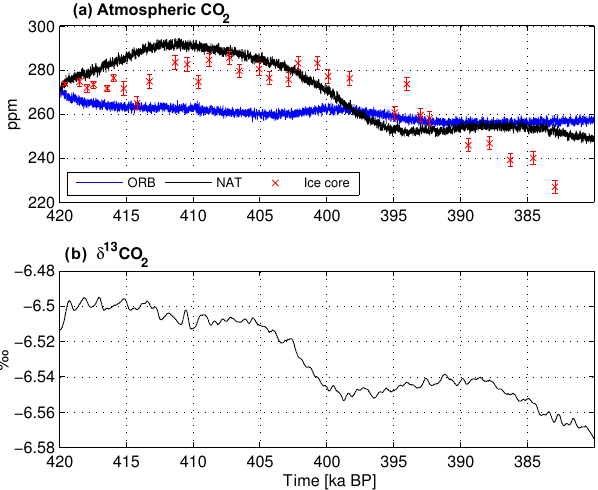
Figure 10. MIS 11 CO 2 concentration (a) from model experi- ments and ice core data, and δ 13 of CO 2 from model experiment MIS11_NAT. δ 13 CO 2 model results have been smoothed for clar- ity. Ice core CO 2 data are from EDC and Vostok as compiled by Bereiter et al. (2015). δ 13 CO 2 from ice cores is not